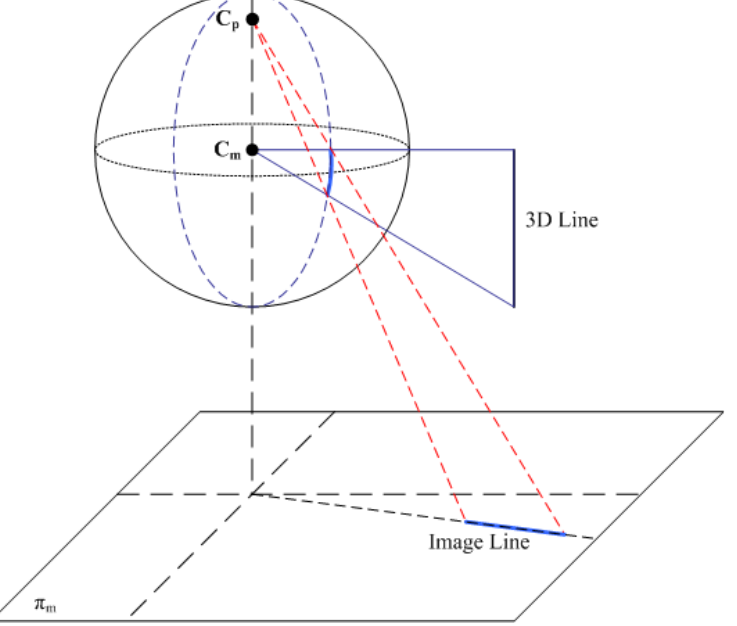
Figure 6. The vertical 3D line in the space is projected to a curve on the unified sphere model via the sphere center at C m